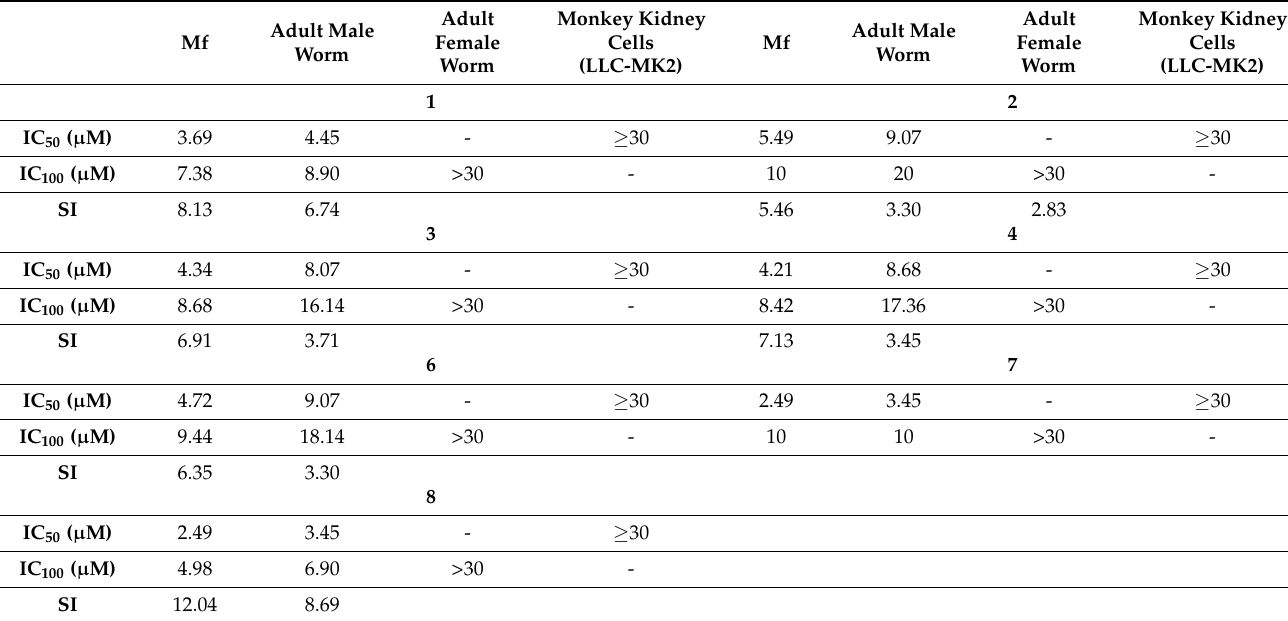
Table 3. IC 50 , IC 100 and selectivity indices (SI) of isolates on O. ochengi microfilariae and adult worms, and monkey kidney epithelial cells (LLC-MK2) in secondary